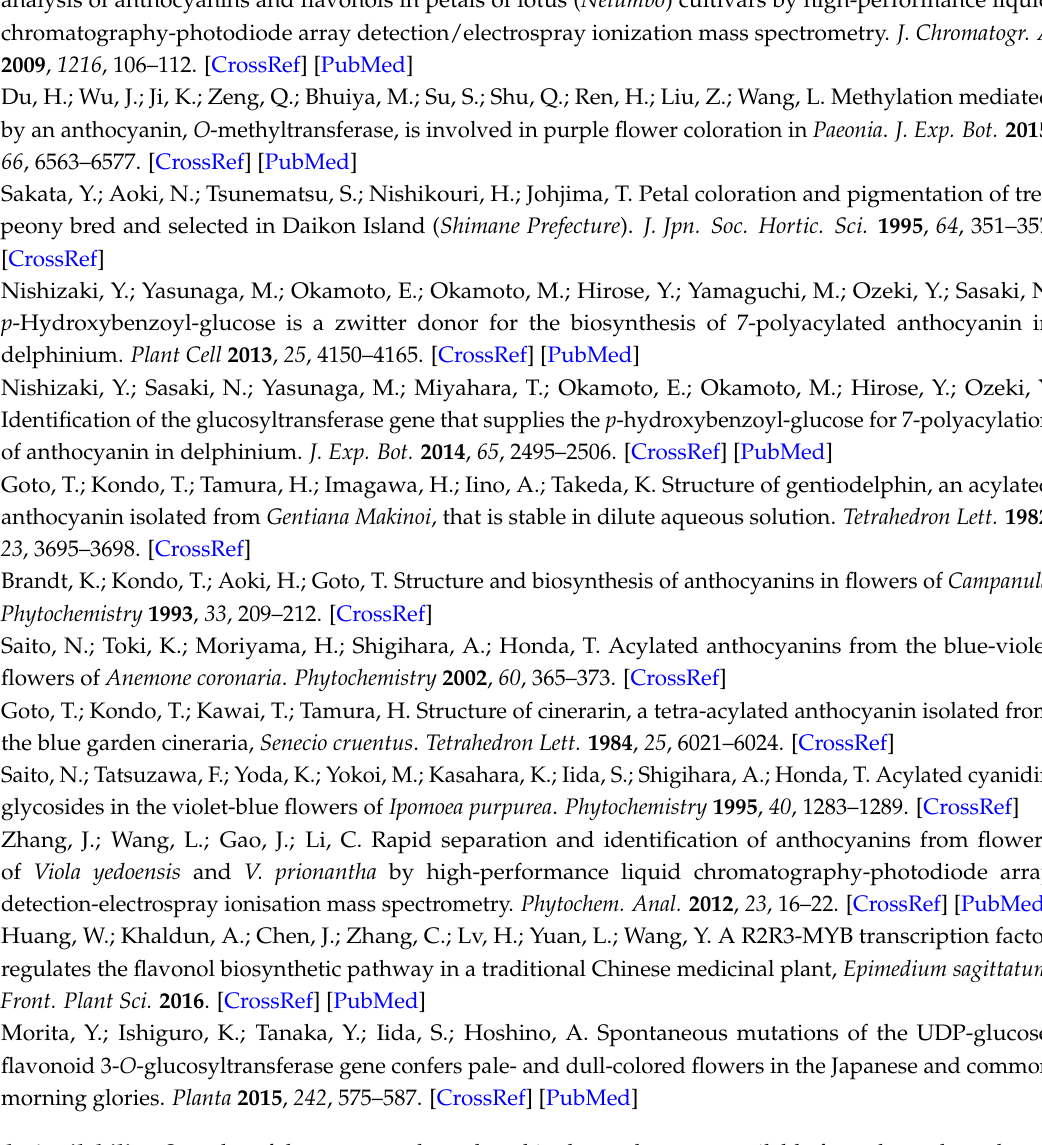
Sample Availability: Samples of the compounds analyzed in the study are unavailable from the authors due to their isolation on a small scale. They are readily analyzed using the procedures